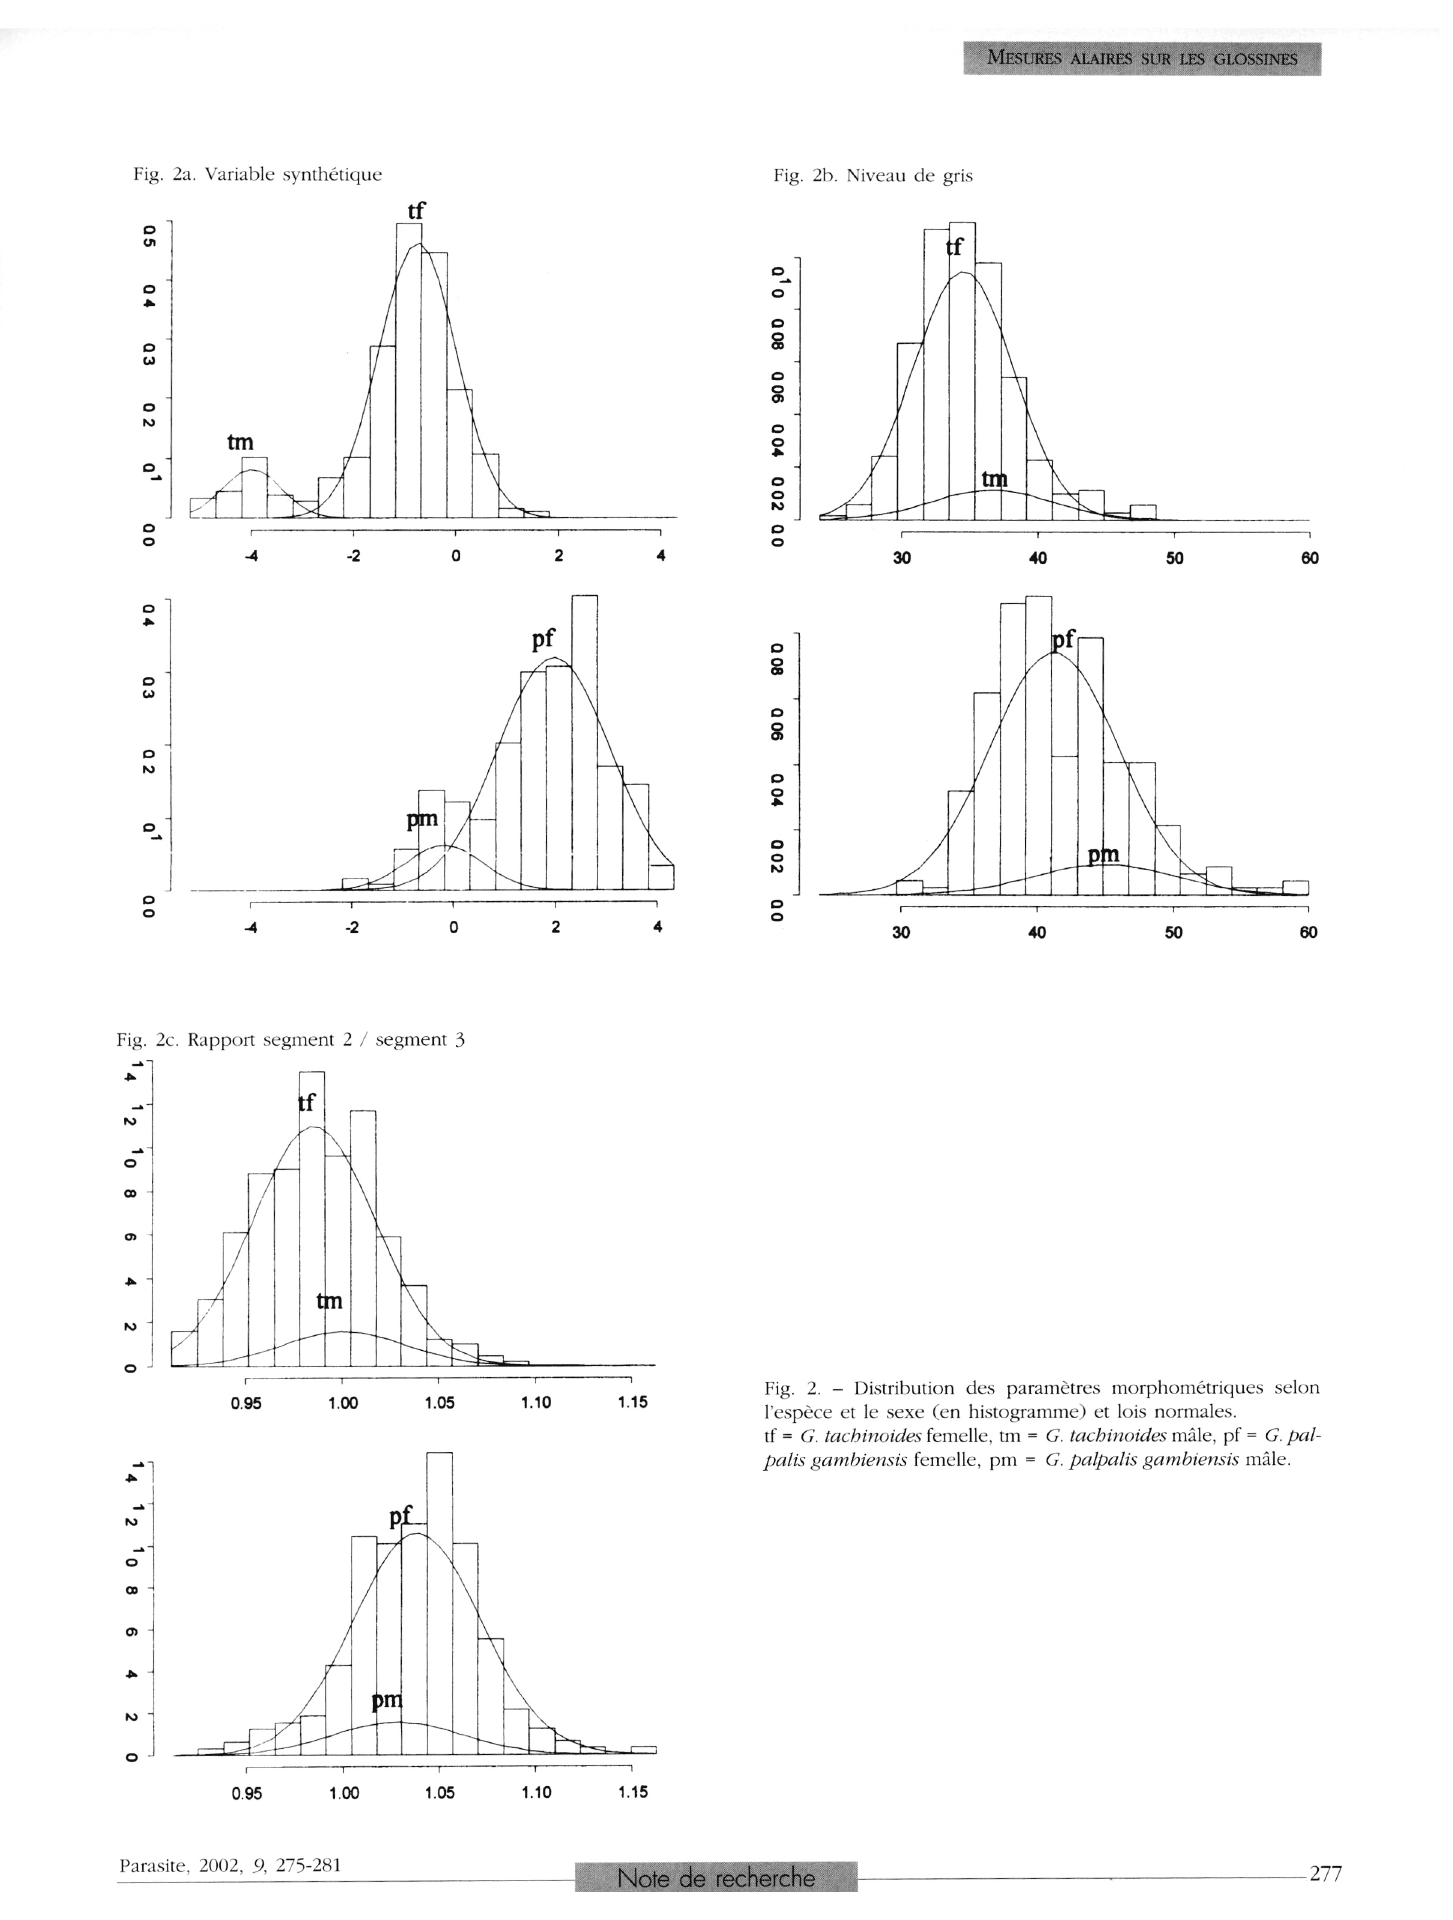
Fig. 2c. Rapport segment 2 / segment 3